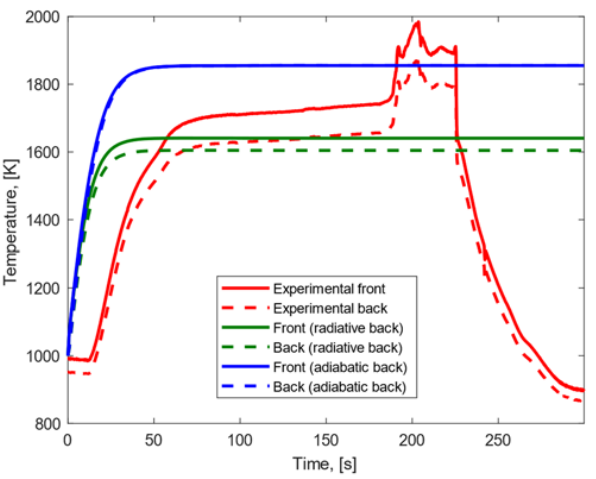
Figure 10. Experimental and modeling temperature profiles for stainless steel AISI316L subjected to high heat flux.